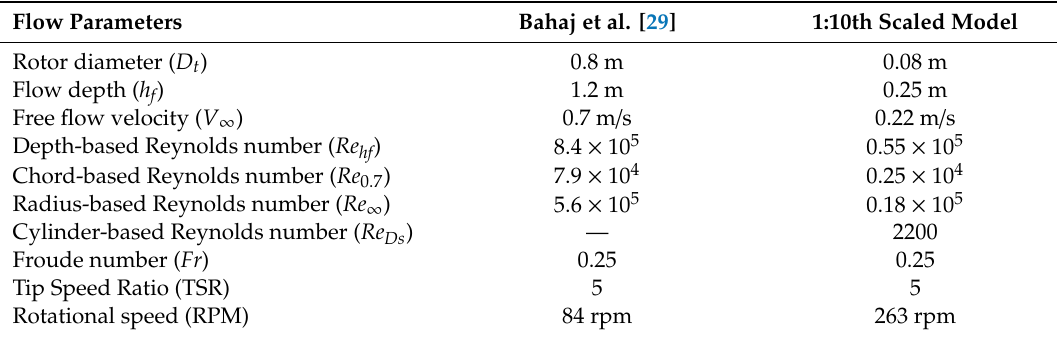
Figure 8. Particle size distribution of seabed scour sand. Table 2. Flow parameters of the flume and tidal